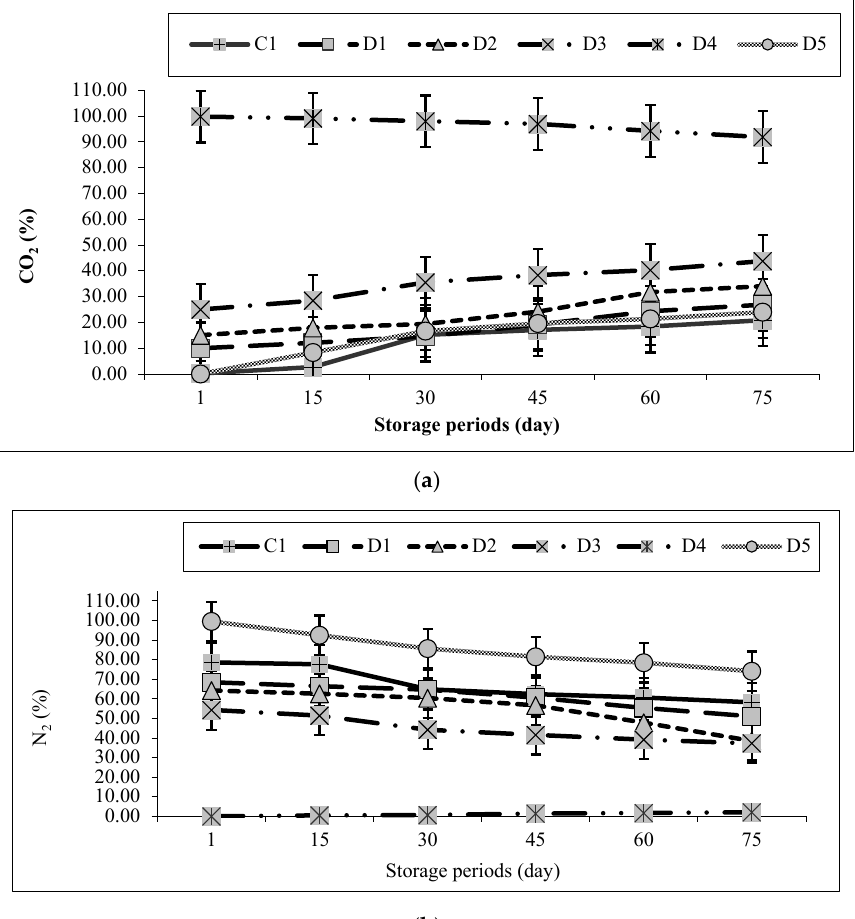
Figure 2. CO 2 ( a ) and N 2 ( b ) levels of the Domiati cheese packaged under different modified atmosphere conditions; C1, control packaged under aerobically atmosphere; D1, 10% CO 2 /90% N 2 ; D2, 15% CO 2 /85% N 2 ; D3, 25% CO 2 /75% N 2 ; D4, 100% CO 2 ; and D5, 100% N 2 . Data are showed with standard errors.